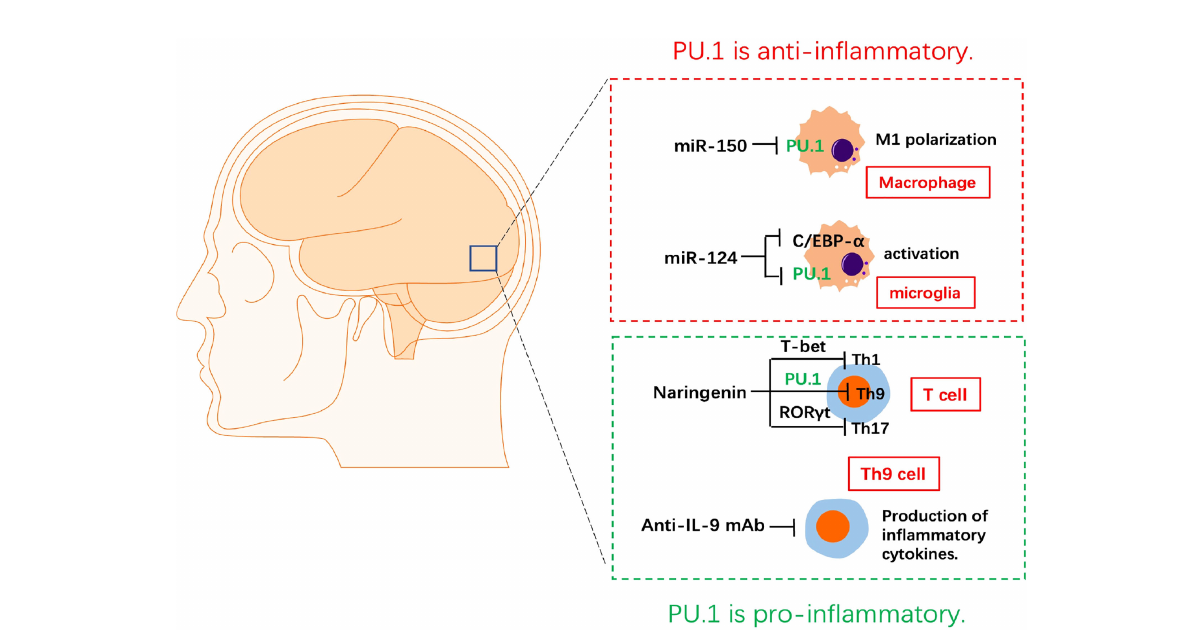
FIGURE 2 The role of PU.1 in experimental autoimmune encephalitis. MiRNA-150 reduces the production of pro-in fl ammatory cytokines and switches macrophage polarization from the M1 to the M2 via targeting PU.1. miR-124 represses the monocyte-macrophage activation via repressing C/ EBP- a and PU.1 in microglia. Naringenin is a potential medicine in the treatment of EAE by inhibiting the Th1(T-bet), Th9(PU.1) and Th17(ROR g t) differentiation of CD4 + T cells. Blocking IL-9 with anti-IL-9 mAb inhibits the development of